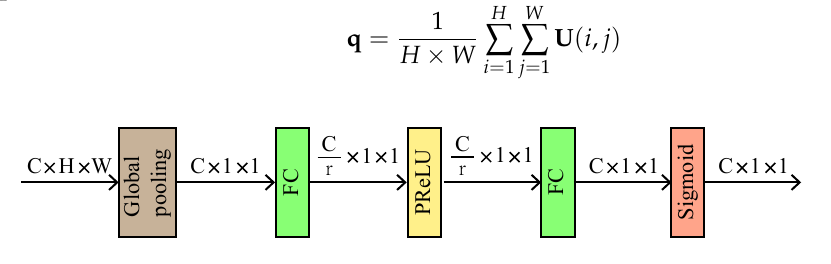
Figure 3. Channel attention (CA)